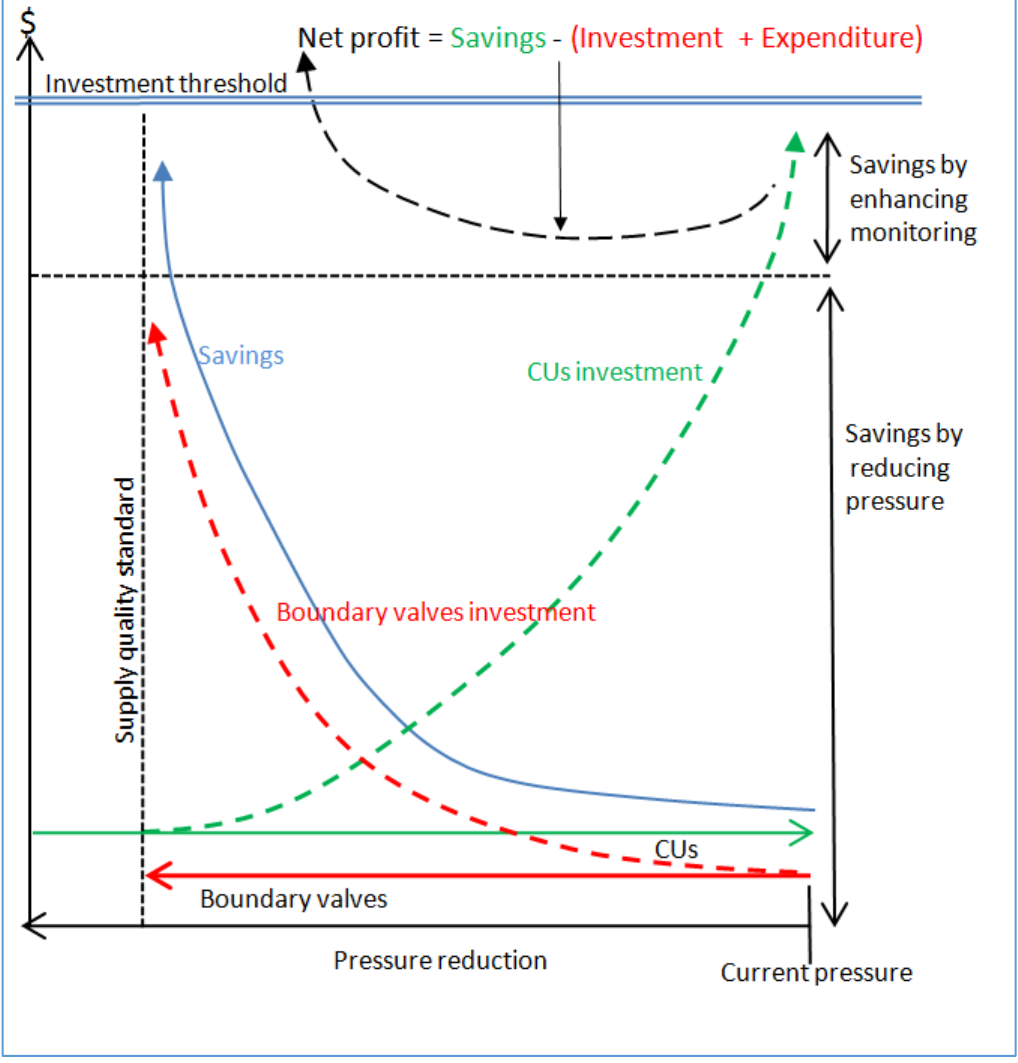
Figure 10. Relation between the benefits and costs of investment.